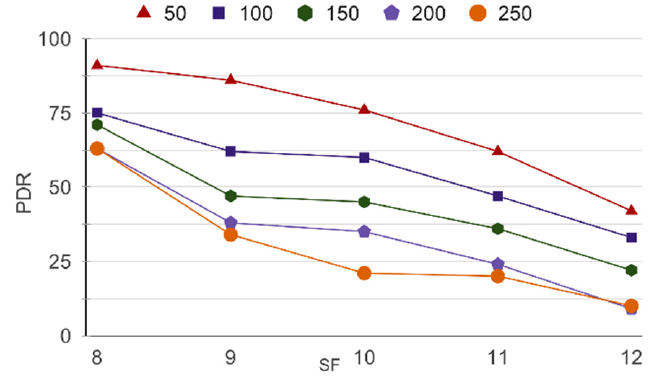
Figure 15. SF versus PDR for a different number of nodes.